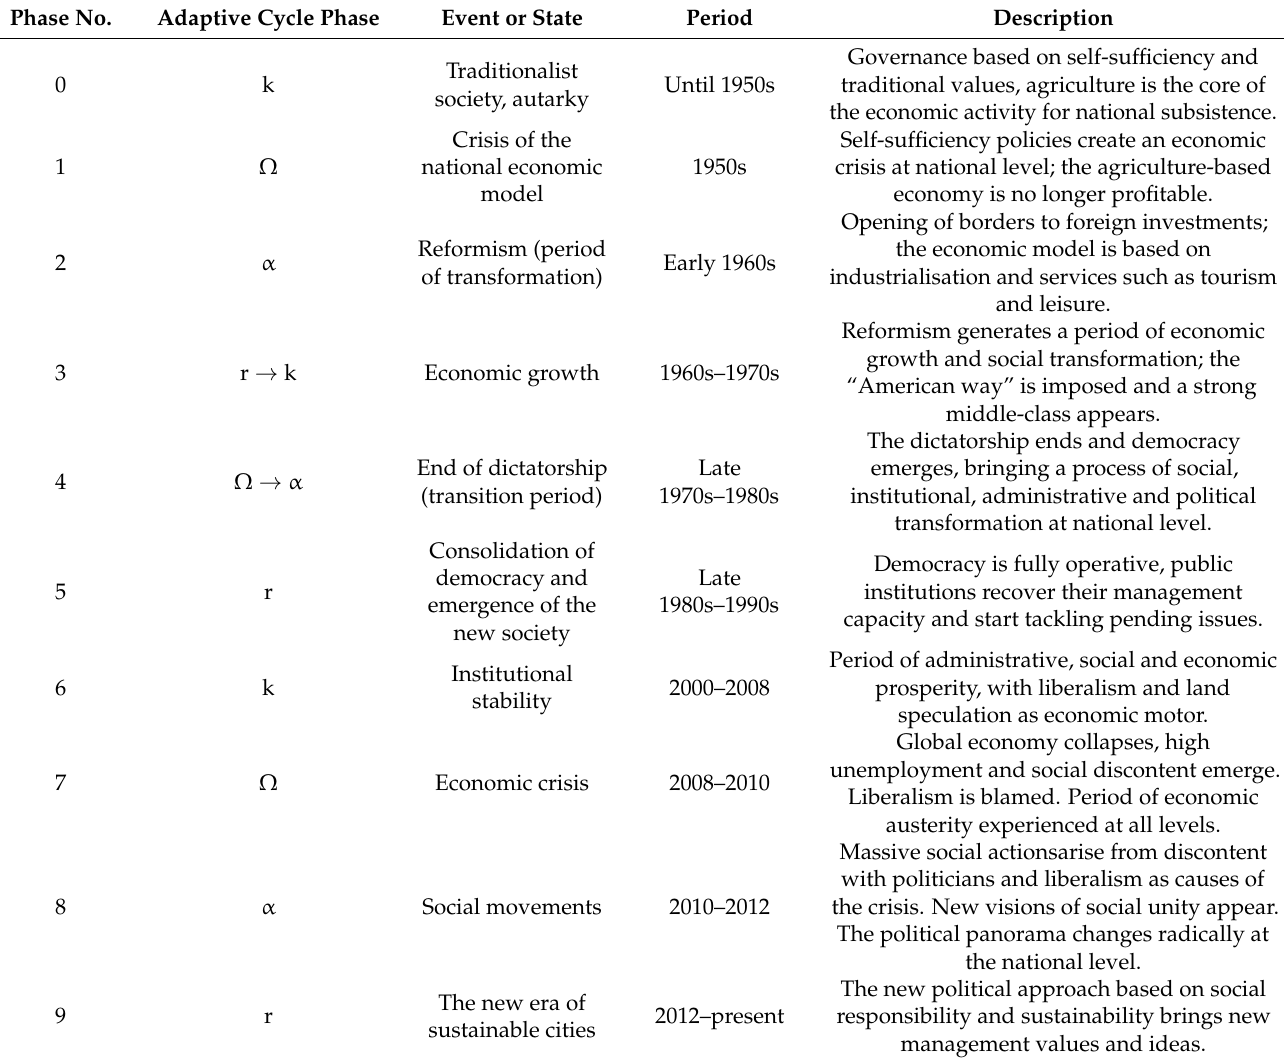
Table 2. Adaptive cycle phases of change in national and local government (the upper level of the panarchy) that influenced change in La Marjaleria. Phase